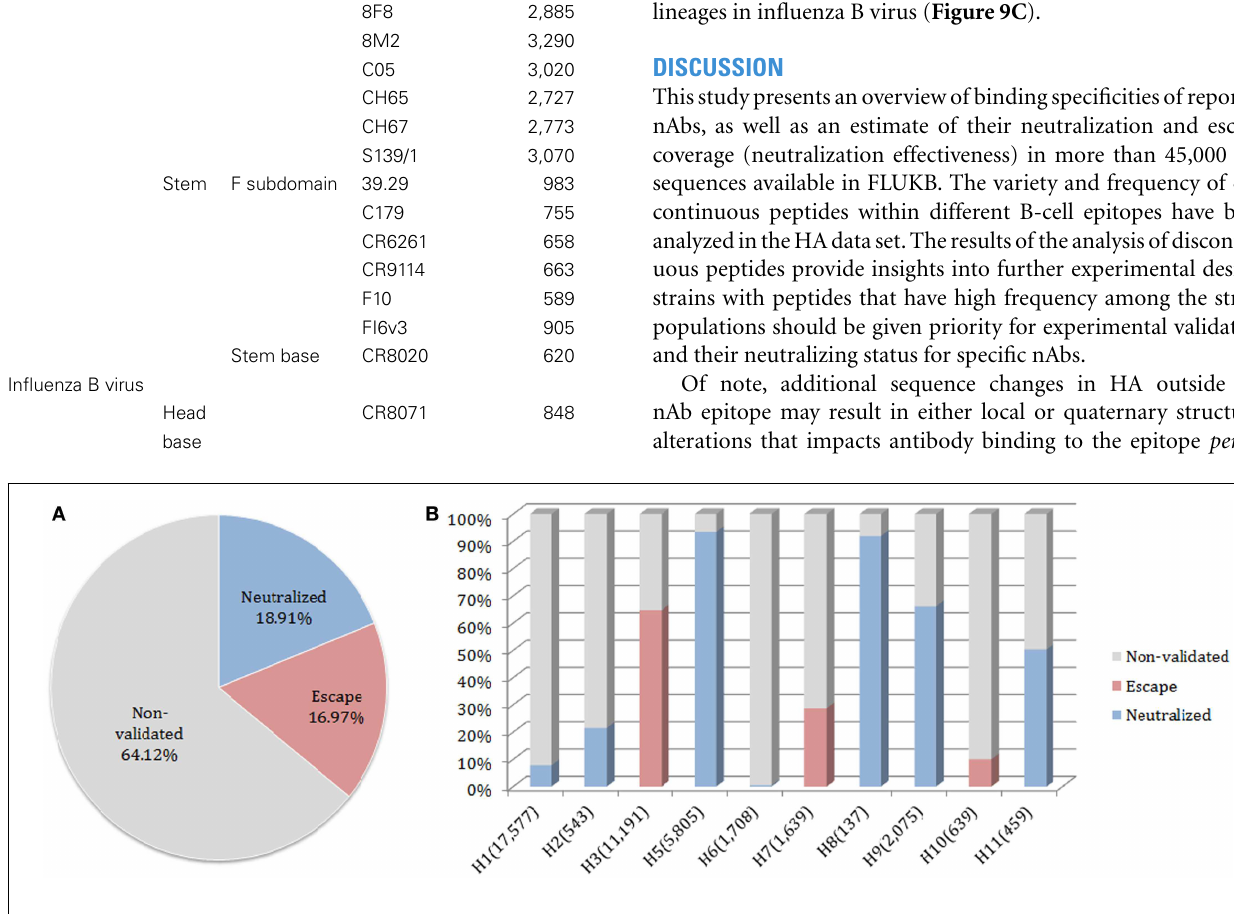
FIGURE 6 | Motif coverage for nAb F10 . (A) The coverage of neutralized and escape discontinuous motifs, and non-validated discontinuous peptides within 45,812 HA sequences extracted from